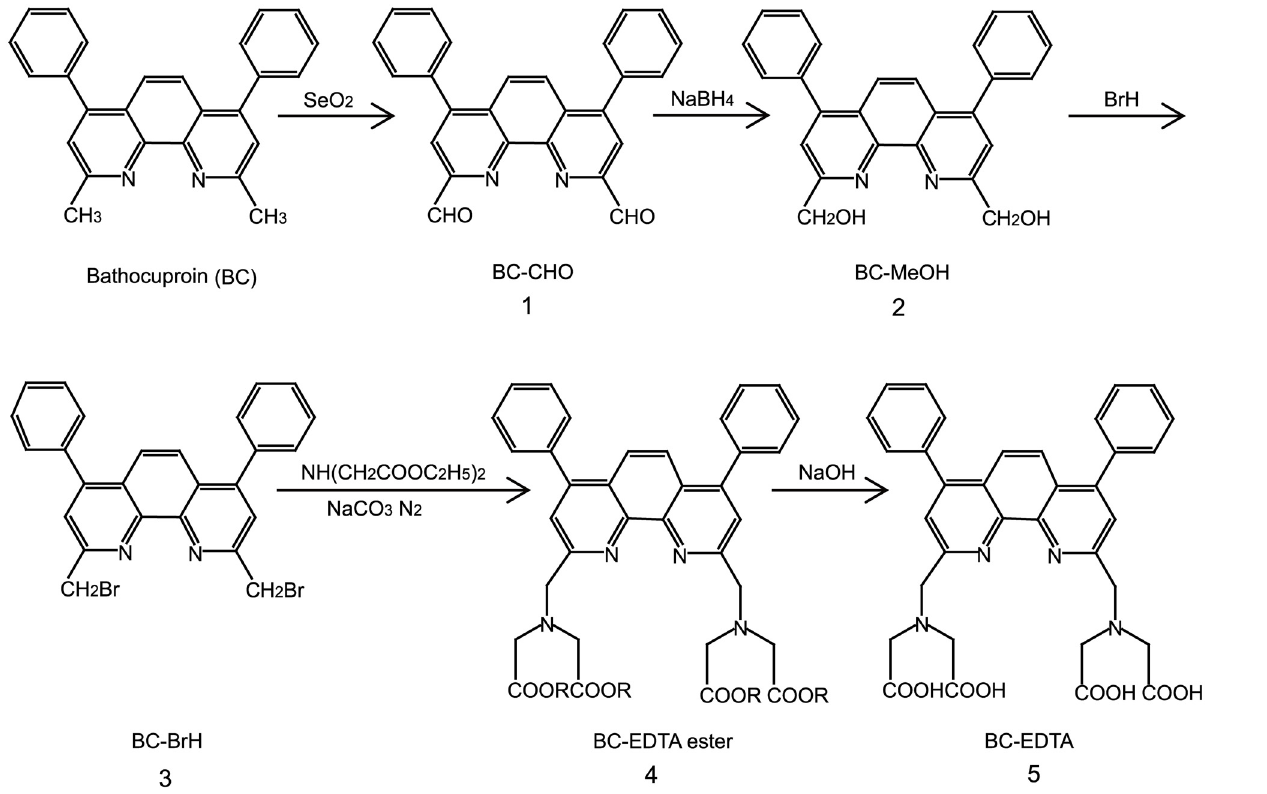
Fig 1. Synthesis of